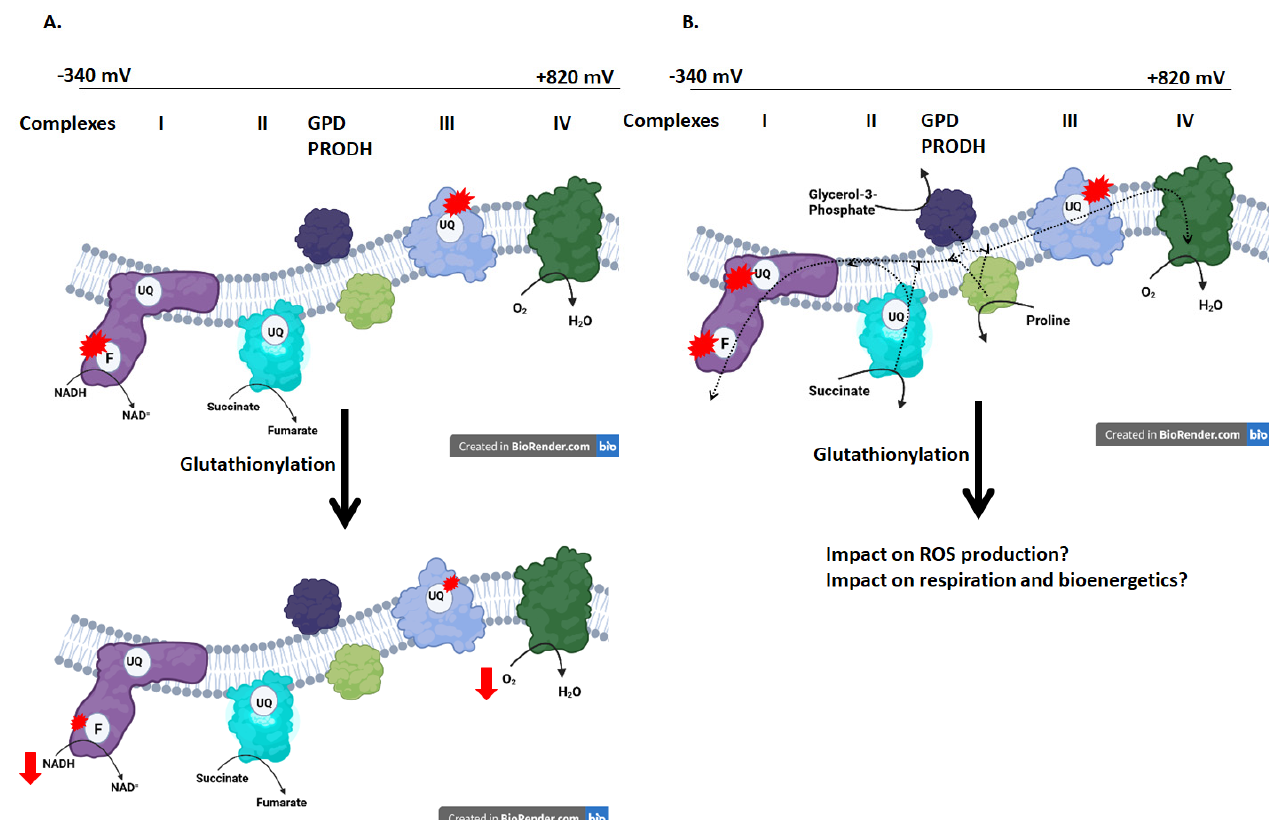
Figure 1. ( A ) Glutathionylation inhibits the NADH oxidizing and ROS generating activity of com- plex I. Modification can occur on many complex I subunits but the addition of glutathione to these components has been omitted for clarity. Modification of NDUFS1, which forms part of the nicoti- namide binding site in complex I, disables ROS production by complex I and ROS sites upstream from complex I by inhibiting electron transfer from NADH to FMN (I F ) and the UQ binding site (I UQ ). Other UQ binding sites are denoted in the other complexes. Note the UQ site in complex III (III UQ ) is a ROS source as well. ( B ) Reverse electron transfer (RET) from nutrient oxidizing enzymes that reduce the UQ pool (complex II or succinate dehydrogenase, GPD; glycerol-3-phosphate de- hydrogenase, PRODH; proline dehydrogenase) can stimulate ROS production by complex I. The effect of glutathionylation on RET-induced ROS production by complex I remains under studied. SPECIAL NOTE: Mitochondria can contain up to 16 ROS generators, 12 of which are associated with bioenergetics and oxidative phosphorylation. These other sites have been excluded for clarity. Figures were generated using